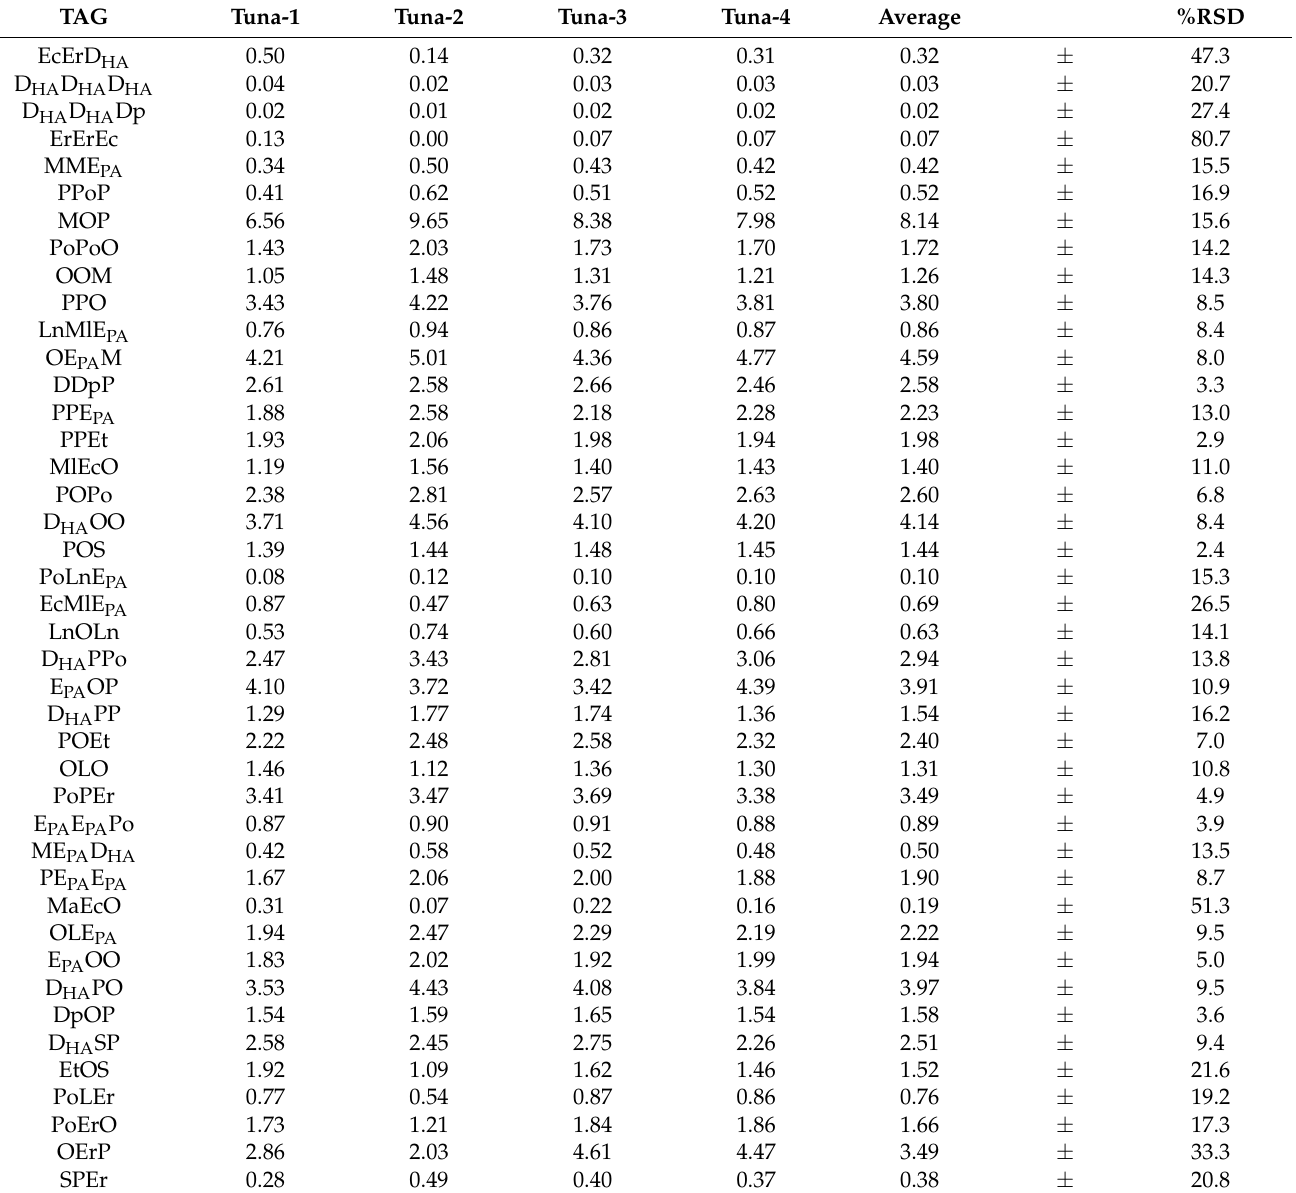
Table 3. Triglycerides tentatively identified and their relative abundances in w / w